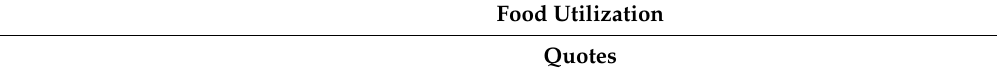
Food Utilization